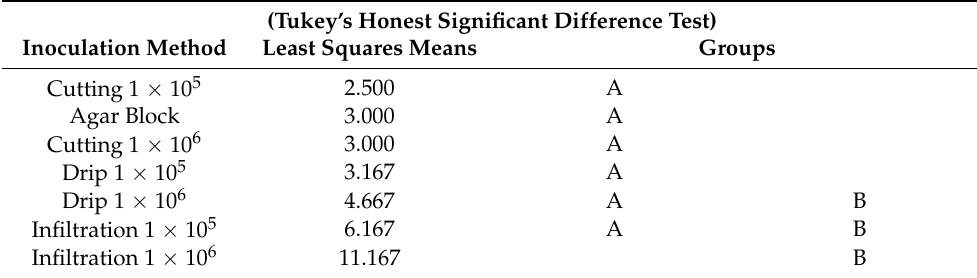
Table 1. Summary of pairwise comparisons for different inoculation